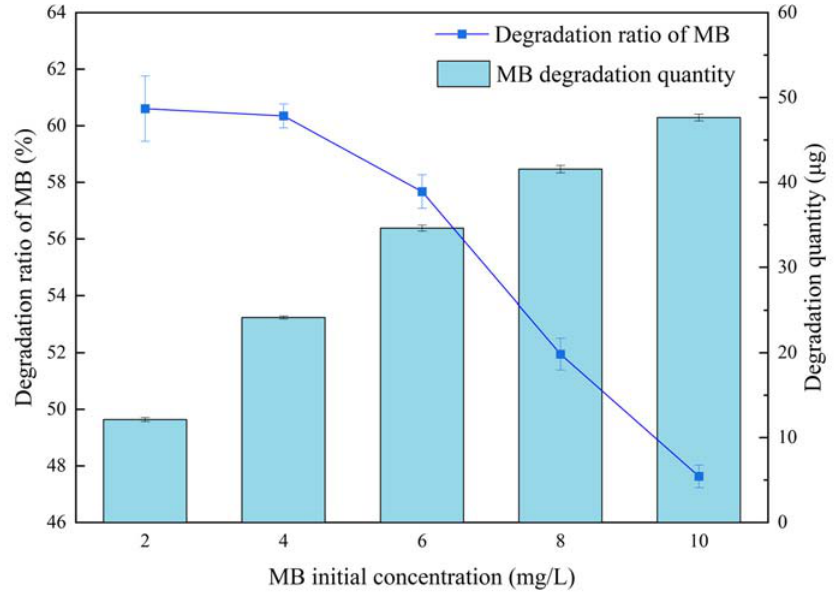
Figure 8. The e (cid:283) ect of MB initial concentration on the photocatalysis degradation of MM-CaTiO 3 . Figure 8. The effect of MB initial concentration on the photocatalysis degradation of MM-CaTiO 3